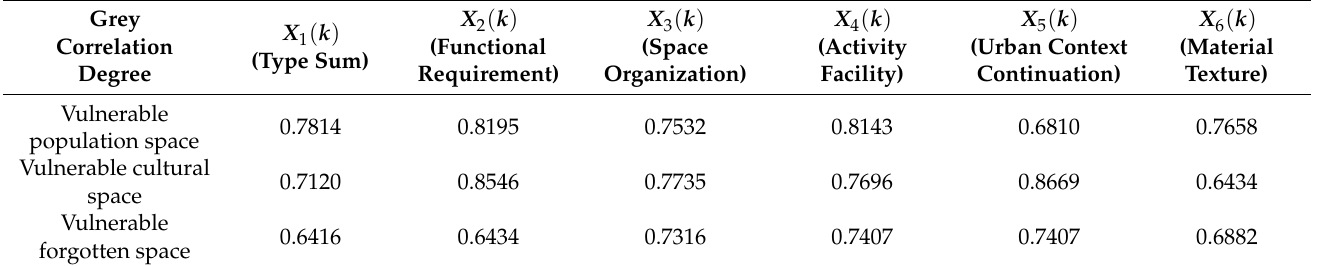
Table 3. Vulnerable space sustainable renewal element